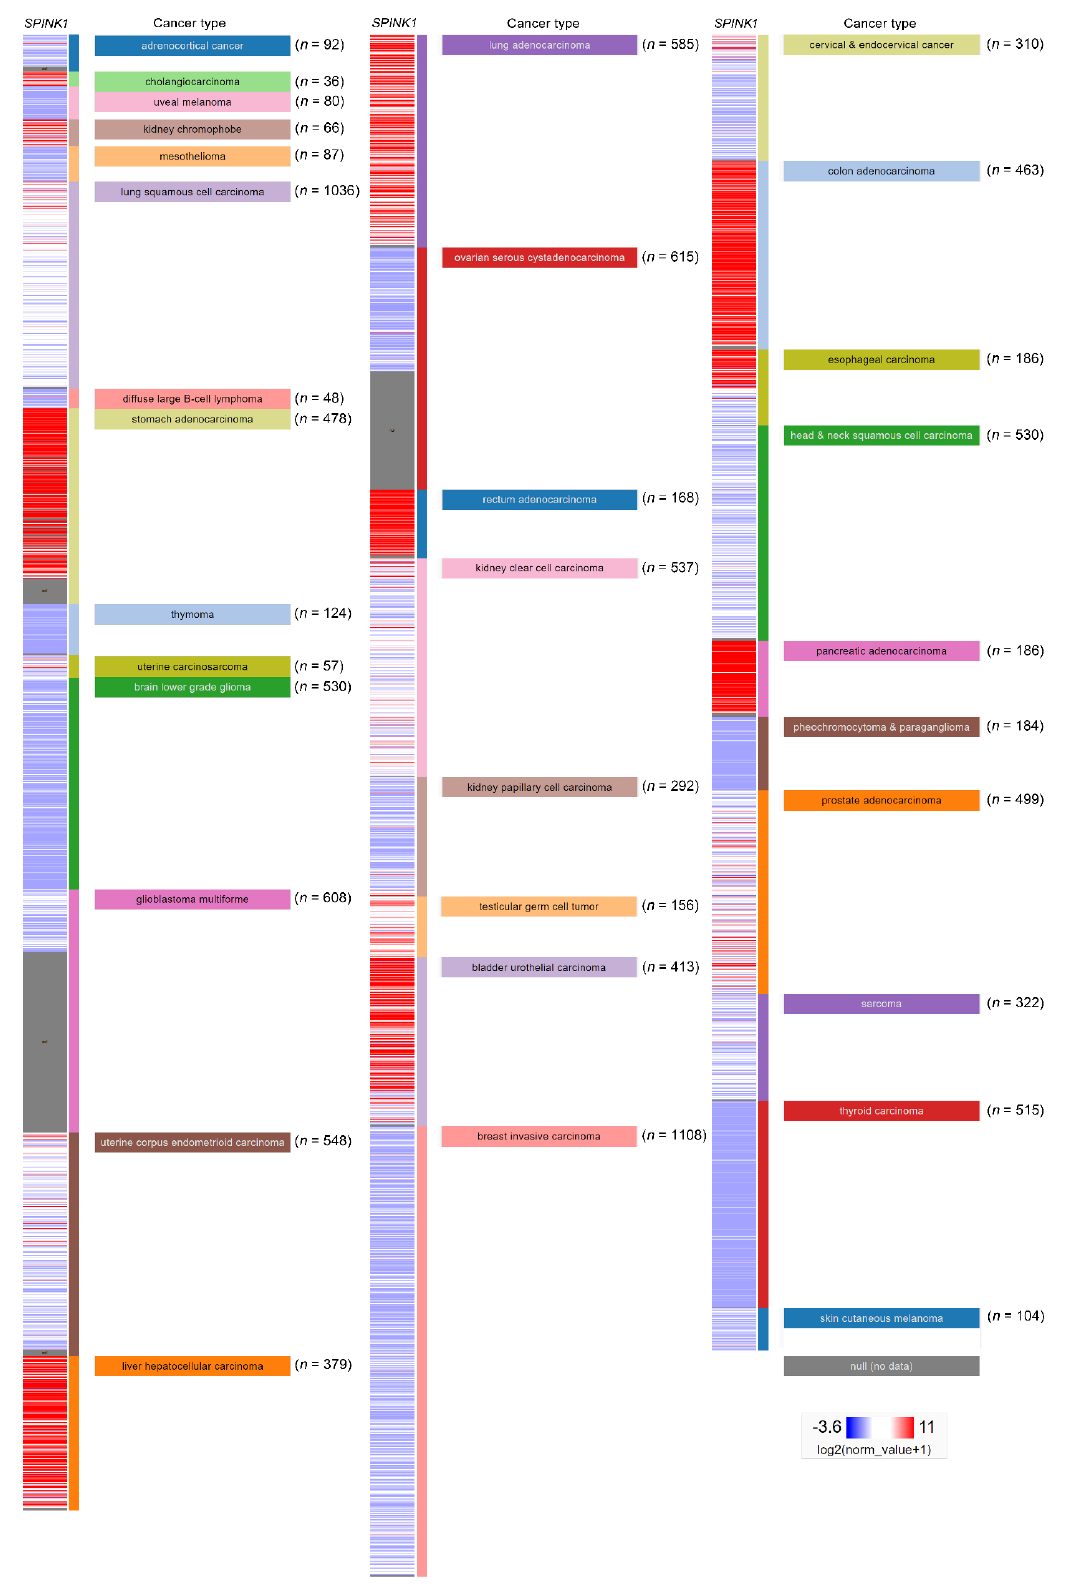
Figure 3. SPINK1 expression view in a pan-cancer panel. In a pan-cancer dataset, SPINK1 expression levels were presented separately for 32 cancer types. The red color in the heat map represents high SPINK1 expression. The blue color in the heat map represents low SPINK1 expression. The raw data were retrieved from The Cancer Genome Atlas (TCGA)